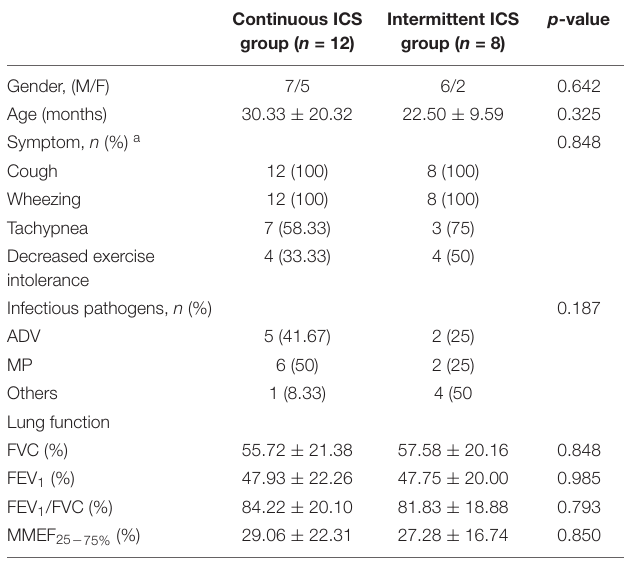
TABLE 3 | Comparison of clinical data between continuous ICS group and intermittent ICS group at baseline (age > 5 years